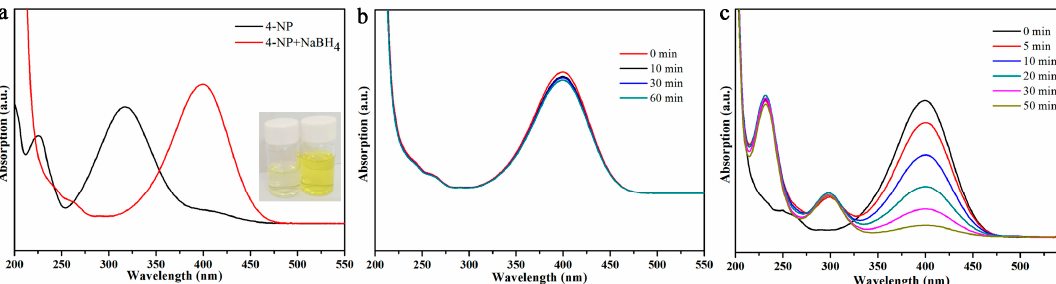
Figure 7. UV-vis absorption curves of 4-NP before and after adding NaBH 4 aqueous solution ( a ); catalytic reduction of 4-NP with MXene ( b ) and PdNPs ( c ).